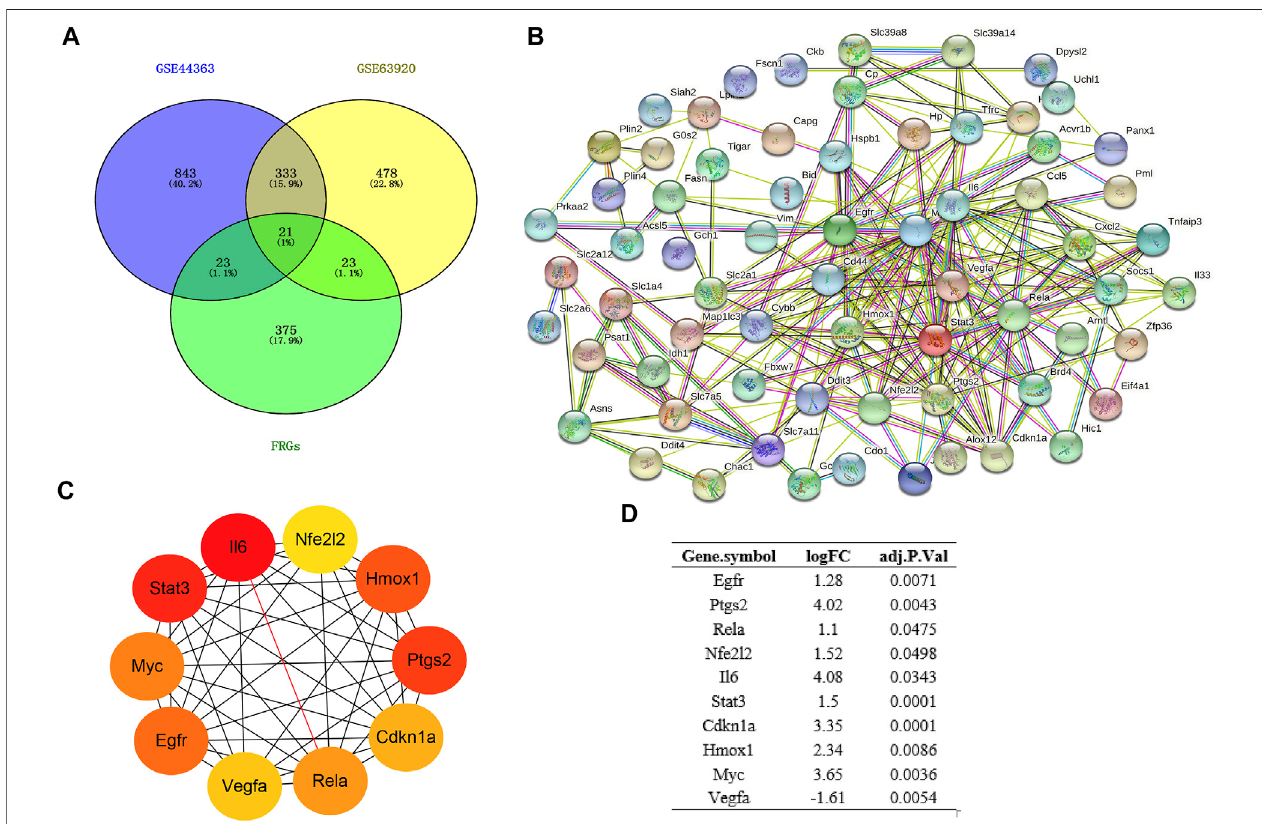
FIGURE 3 | Construction of PPI network and Identi fi cation of hub genes. (A) Venn diagram of DEGs between DEmRs and FRGs; (B) PPI network of DEFRGs constructedbySTRINGdatabase; (C) thetop10hubgeneswereidenti fi edbyMCC; (D) thelogFCandadjusted p -valueofthehubgenes.DEGs,differentiallyexpressed genes; FRGs, ferroptosis-related genes; DEFRGs, differentially expressed